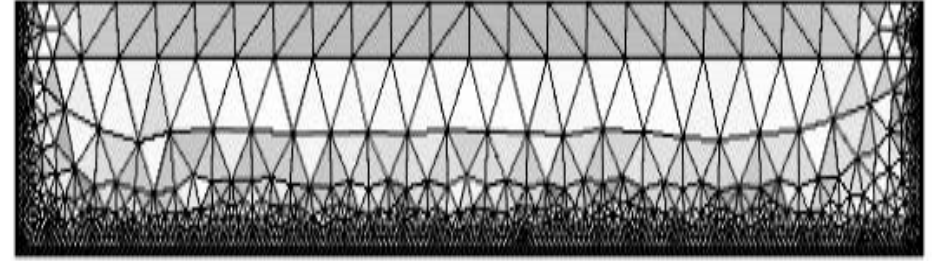
Figure 3. Meshing of a cylindrical 18650